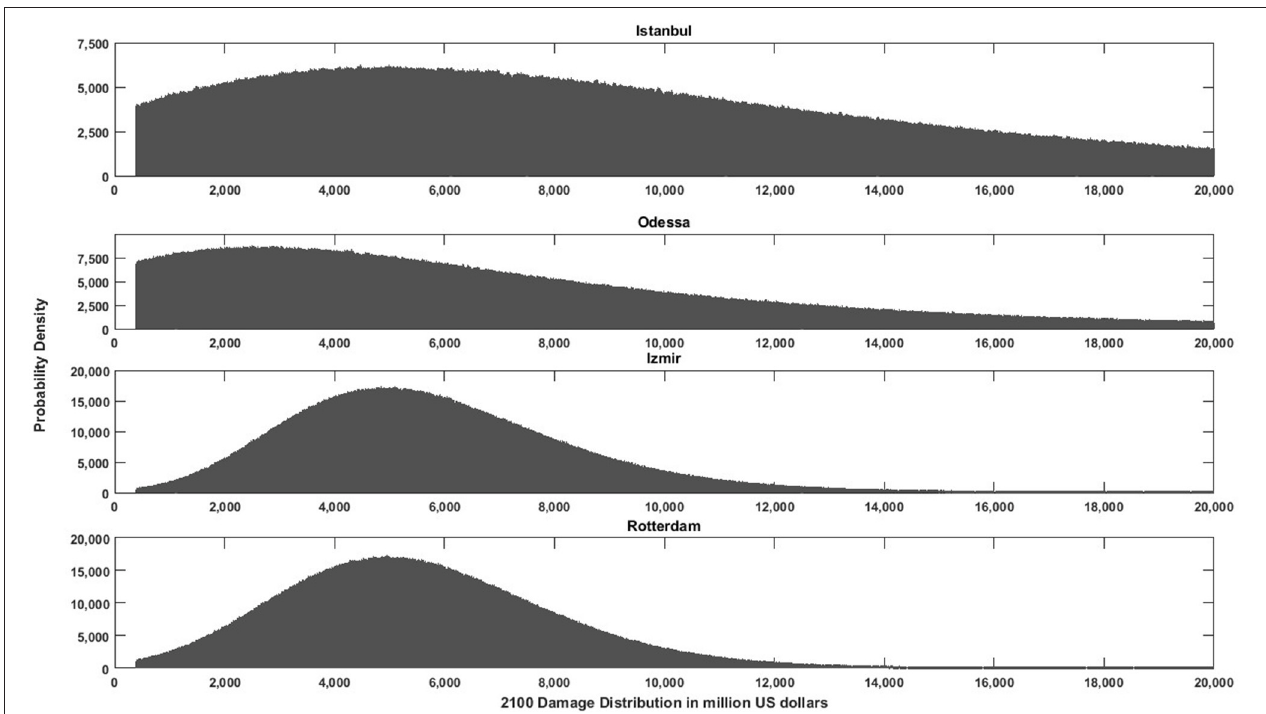
FIGURE 2 | Damage distribution in 2100 and uncertainty distributions for the top 4 European cities under RCP8.5. Note that the vertical scale differs depending on the city.